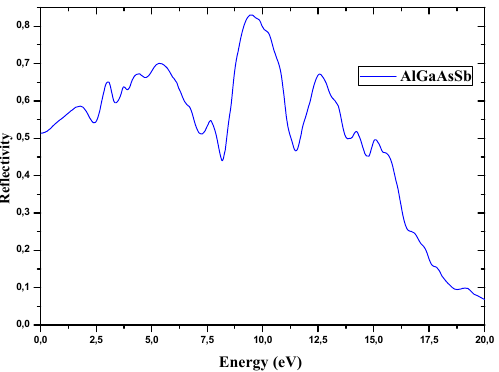
Figure 9. Reflectivity of the nanostructured Al 0.125 Ga 0.875 Sb 0.75 As 0.25 within the 0 − 20 (and 35) eV energy range.